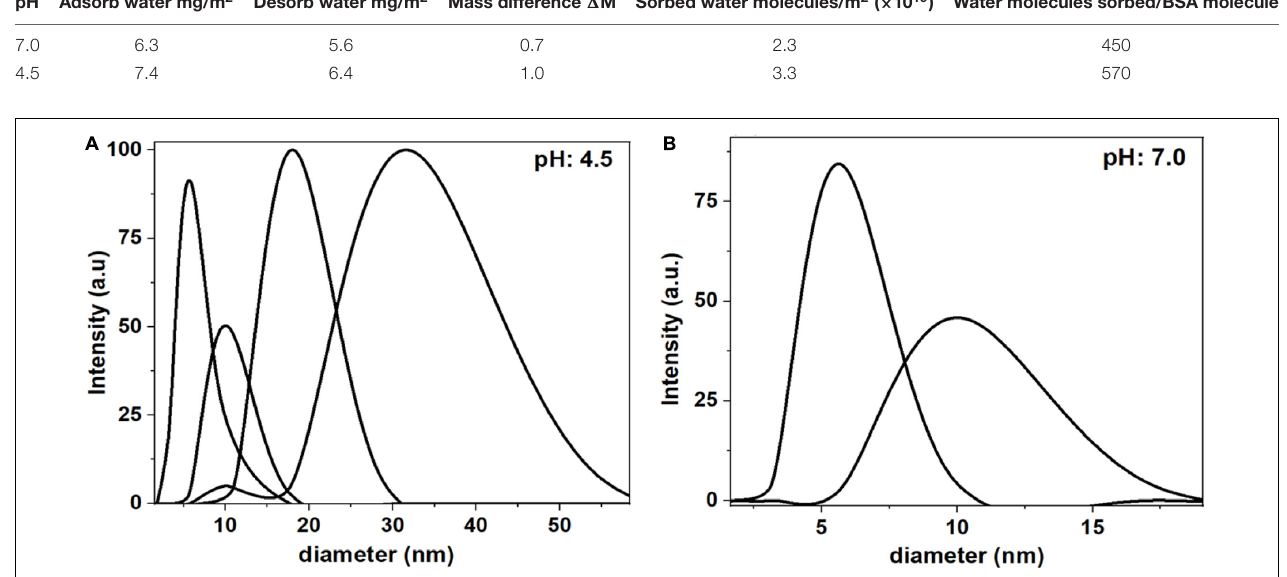
TABLE 1 | Adsorbed mass (mg/m 2 ) from modeling the QCM-D data with the Sauerbrey model.